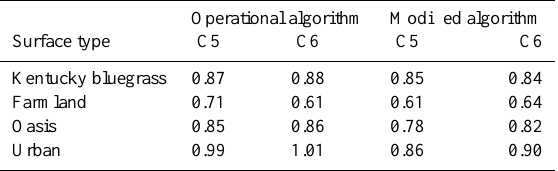
Table 5. Retrieved AOD(0.55µm) for different surface types and different slope parameters as listed in Table 4 for the C5 and C6 algorithms. The reflectance at TOA, input parameter in the retrieval algorithm, was simulated for AOD(0.55µm) =